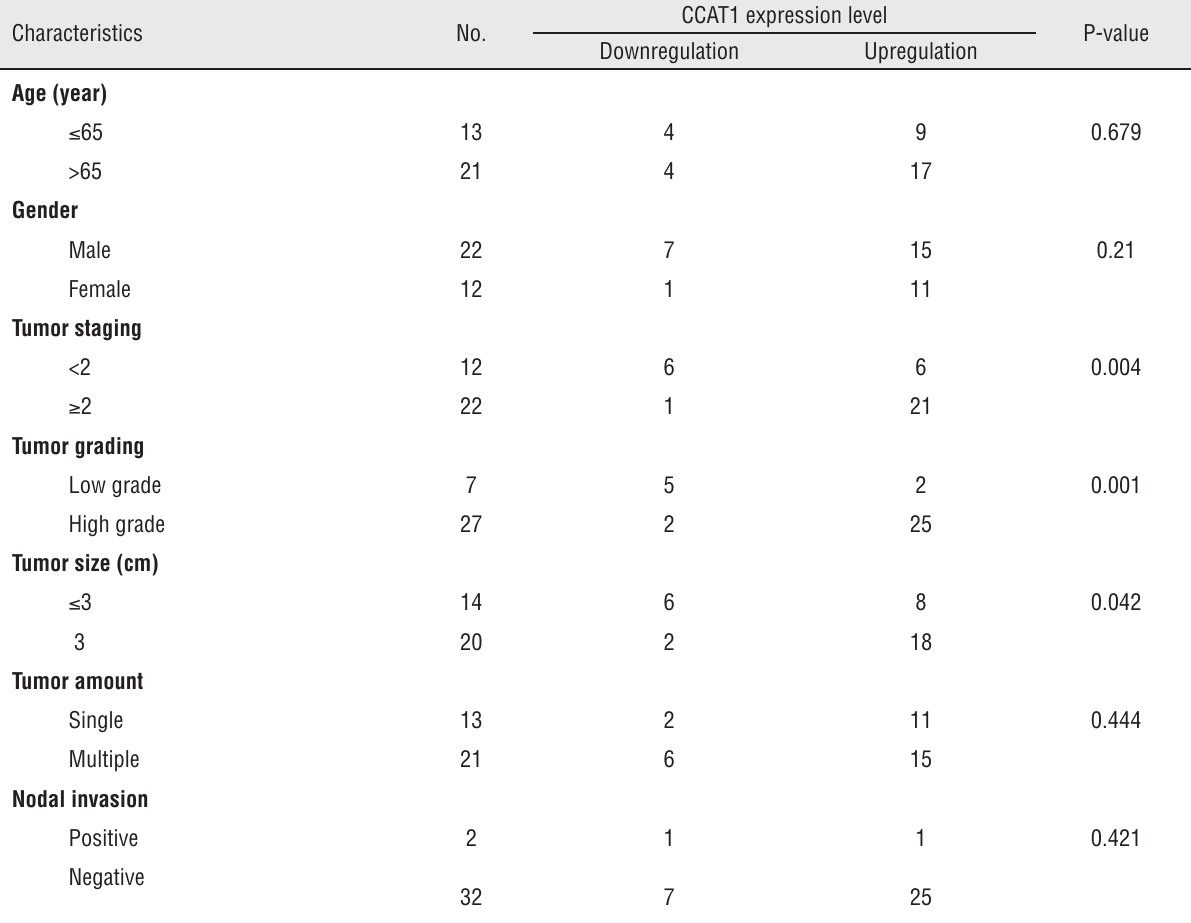
Table 1 - Relationship between CCAT1 expression and clinicopathological characteristics of bladder cancer patients. Characteristics